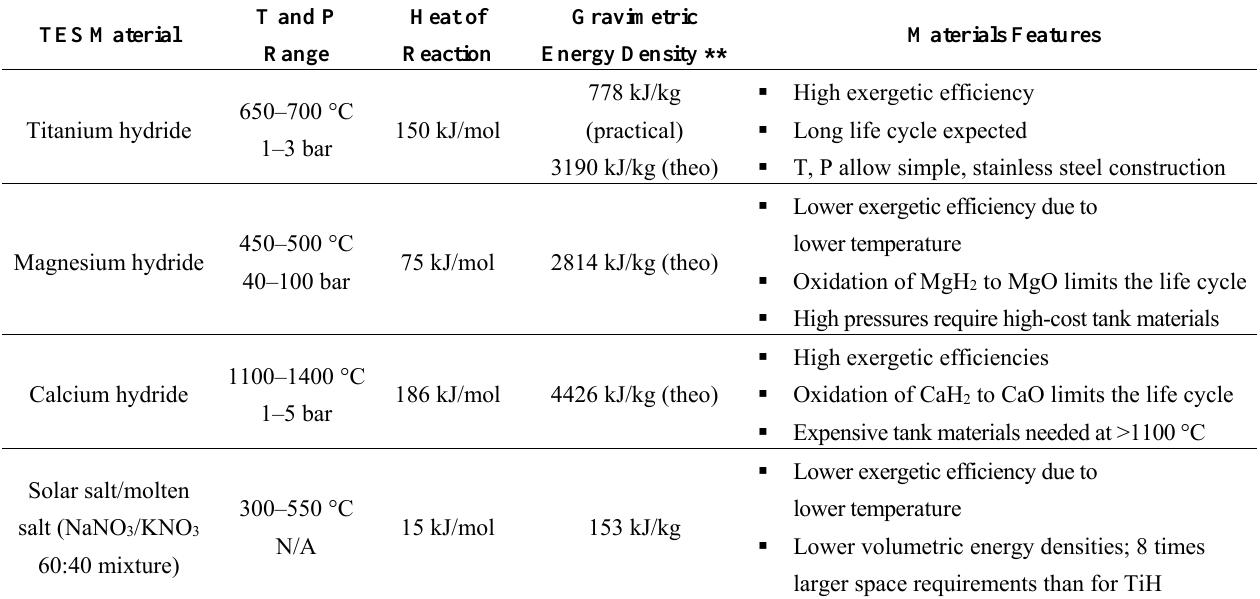
Table 1. Comparison of titanium hydride with other heat storage technologies. TES, thermal energy